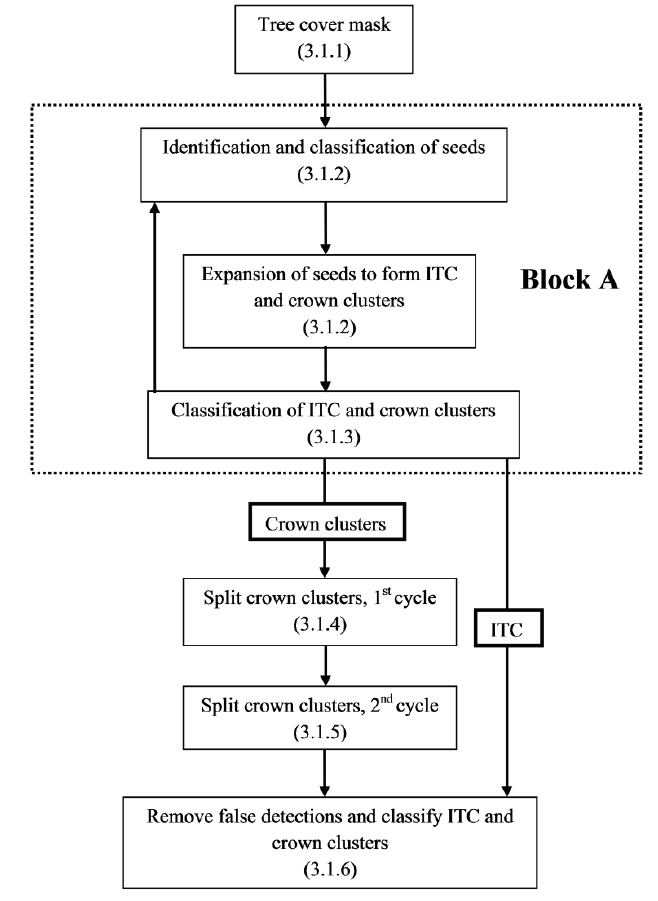
Figure 3. Flowchart of the GEOBIA processing steps and their sections in the paper. Block A (inside the dotted line) is repeated to split crown clusters (Section